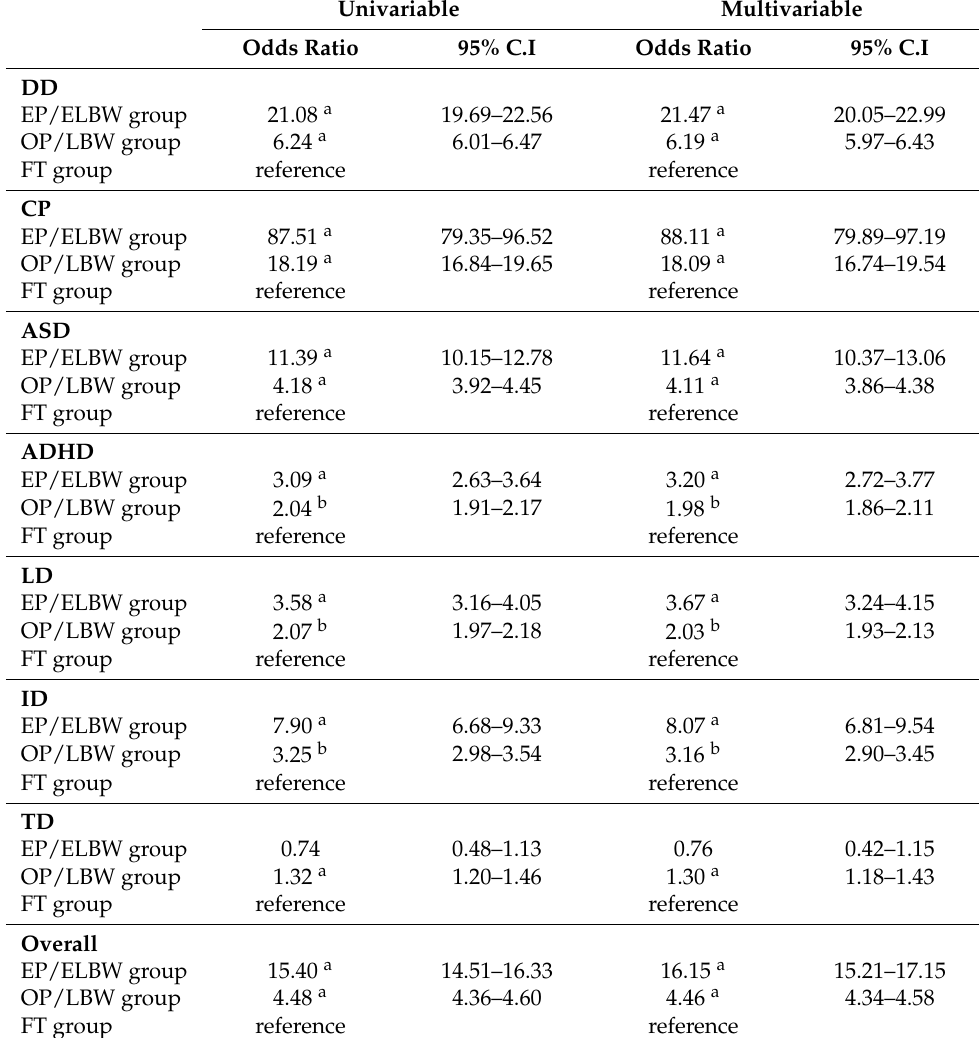
Table 3. Multivariable logistic regression model presenting the association between the probability of neurodevelopmental disorders and preterm birth adjusted for sex and socioeconomic status.